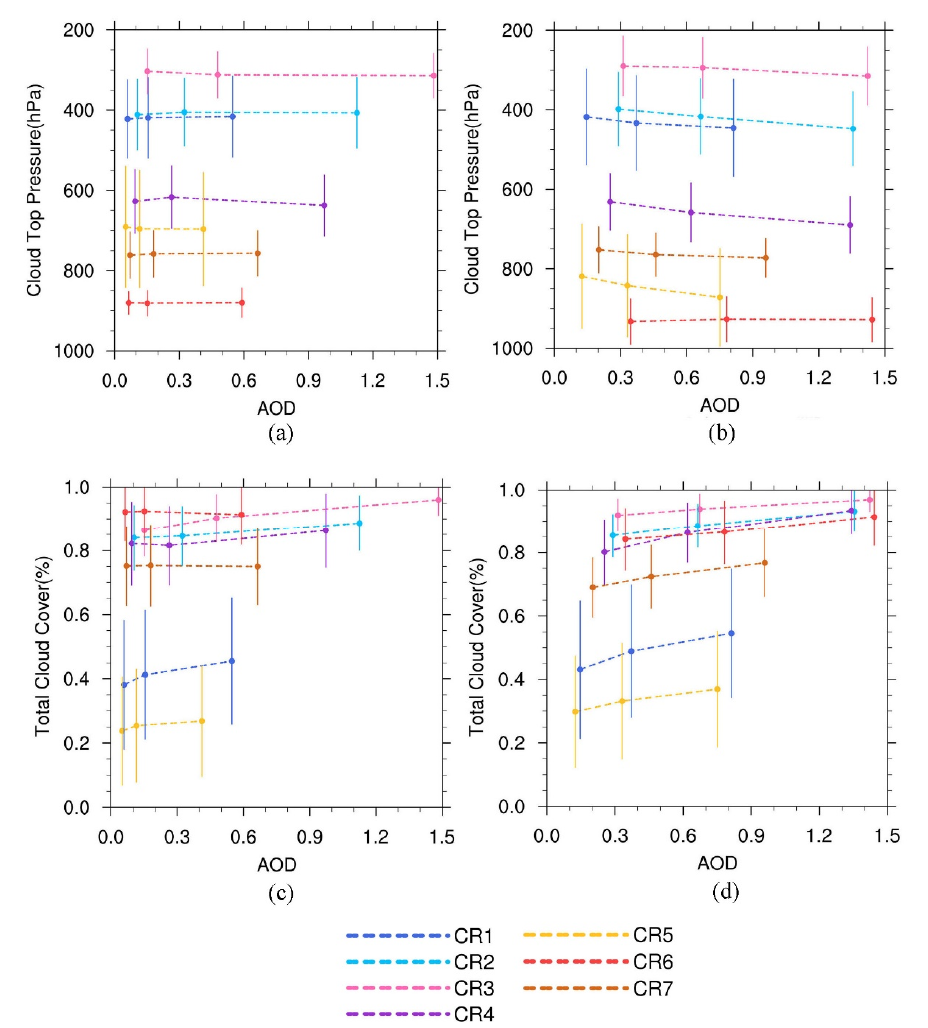
Figure 9. Variations of ( a ) CTP in the western China, ( b ) CTP in the eastern China, ( c ) TCC in the west China, and ( d ) TCC in the east China with AOD. The vertical bars represent ± one standard error.